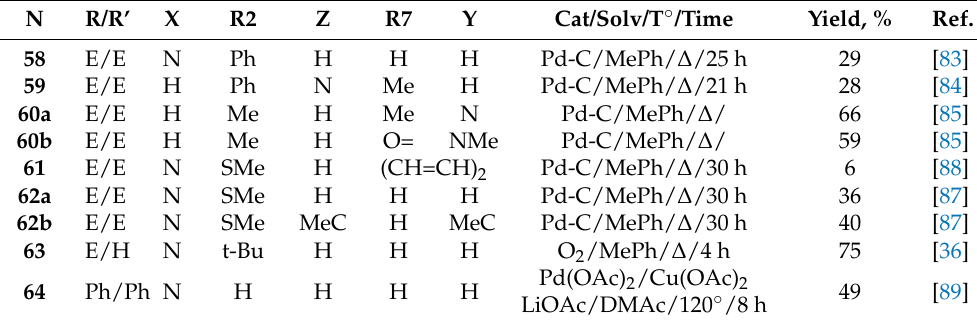
Table 15. Substituents and yields of reaction of 2-arylimidazopiridines and diarylacetylenes (Scheme 33). N